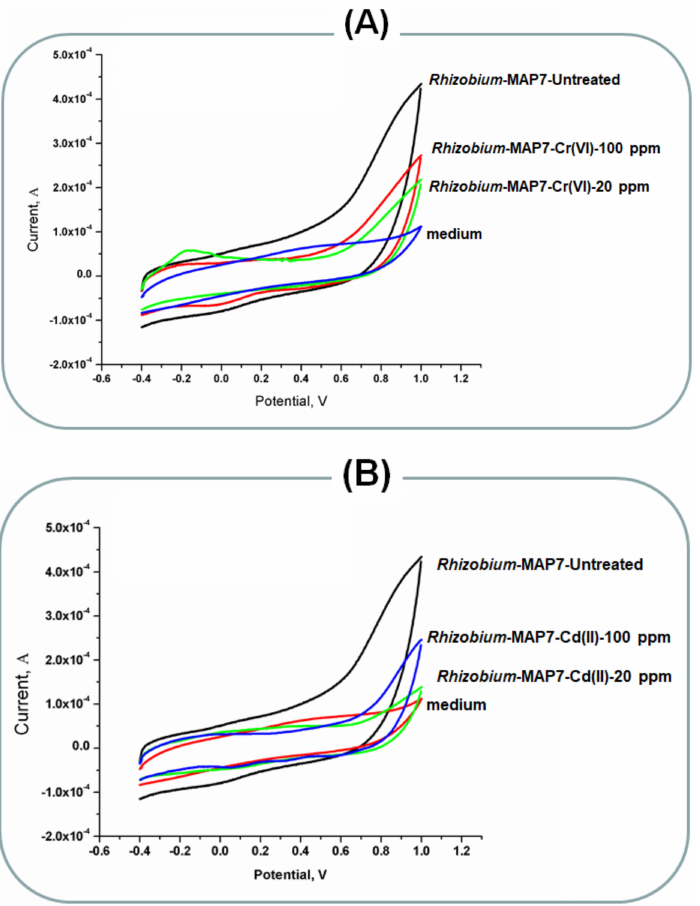
Figure 4. ( A ) Bio-electrochemical responses of biofilm formed Rhizobium -MAP7 treated with different concentrations of Cr(VI). The untreated cells were considered as the positive control and ( B ) bio- electrochemical responses of biofilm formed Rhizobium -MAP7 treated with different concentrations of Cd(II). The untreated cells were considered as the positive